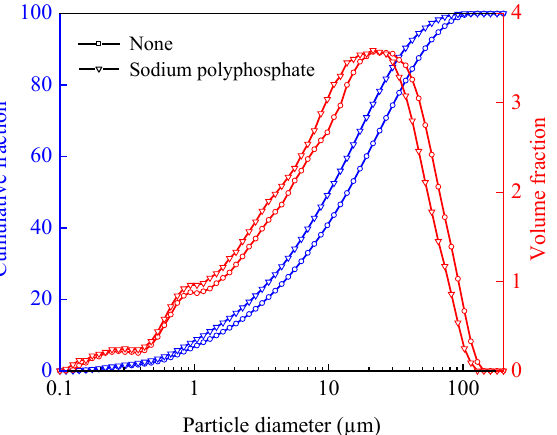
Figure 3. Particle size distribution curves of coal slime under the action of SPP (SPP:1000 g/ t ). Table 2. The grain size parameters of samples.